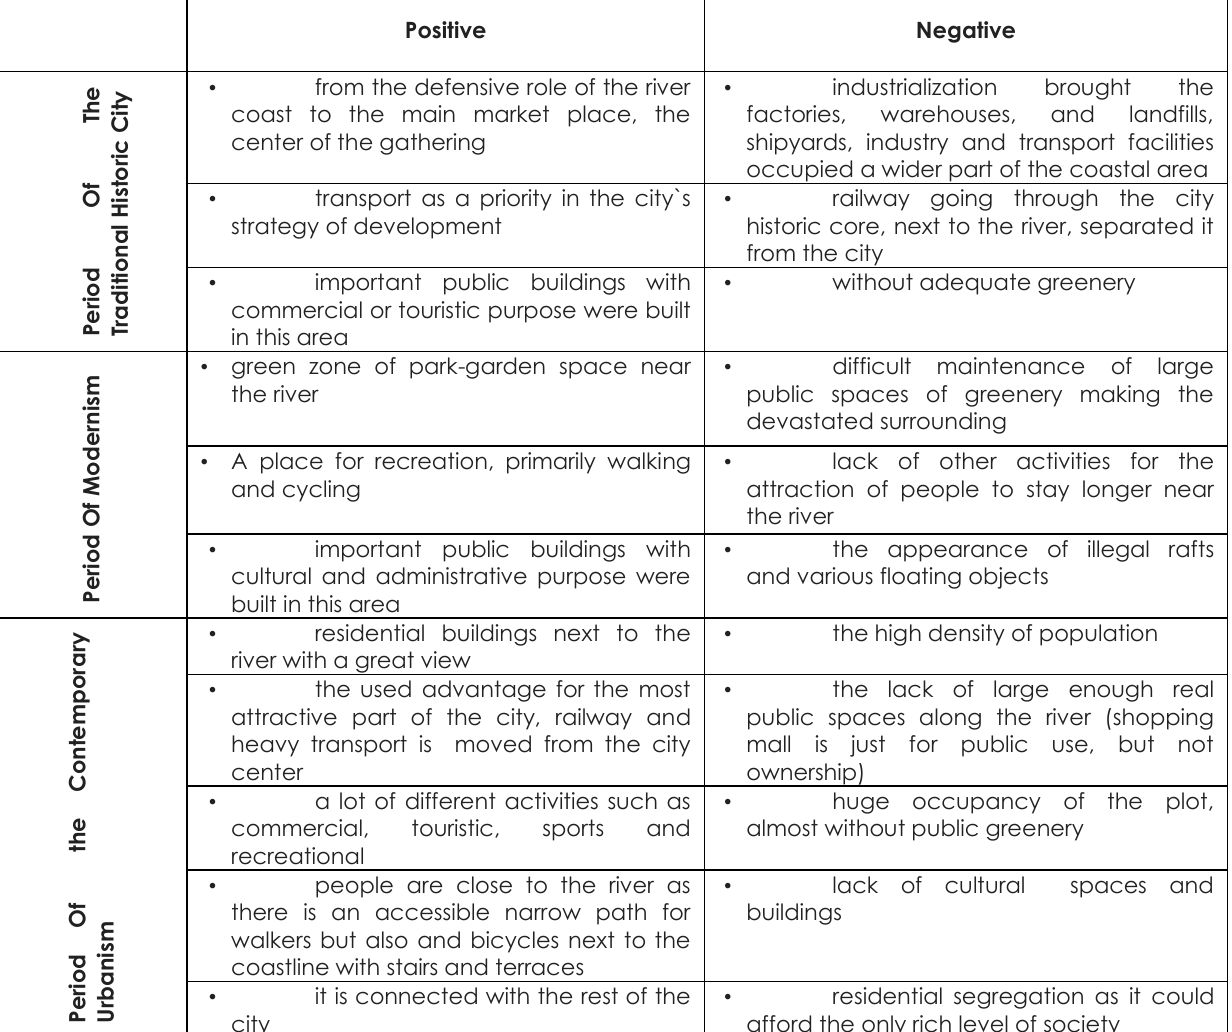
Table 1 . Main characteristics for the three observed periods with different treatment of river waterfront Positive